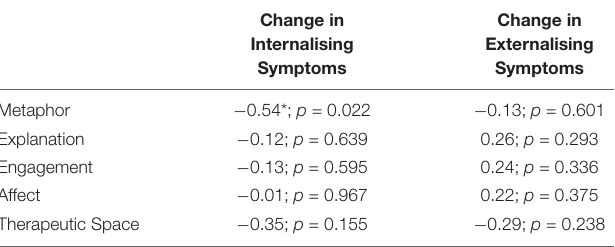
TABLE 6 | Spearman’s correlations (r s ) of therapist variables (Metaphor, Explanation, Engagement, Affect, and Therapeutic Space) and the CBCL change scores (Internalising and Externalising).